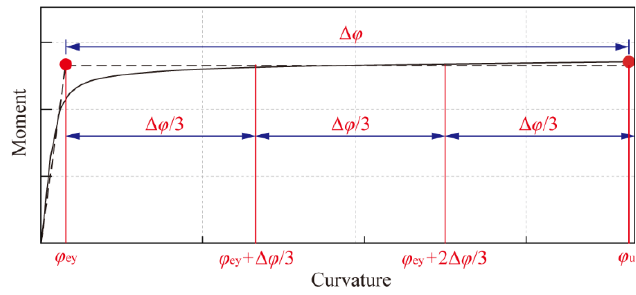
Figure 10. Limit states for the pylons.